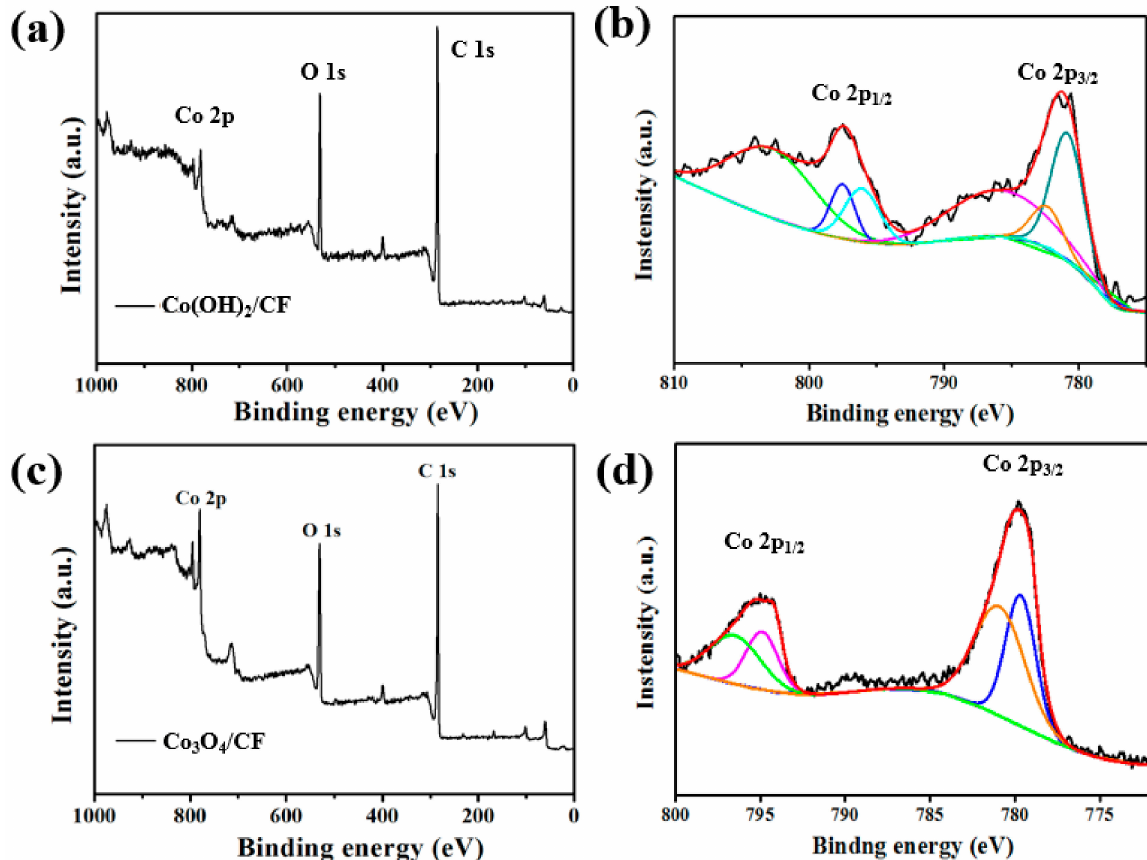
Figure 3. ( a ) XPS survey spectrum, ( b ) Co 2p of an Co(OH) 2 /CF, and ( c ) XPS survey spectrum, ( d ) Co 2p of an Co 3 O 4